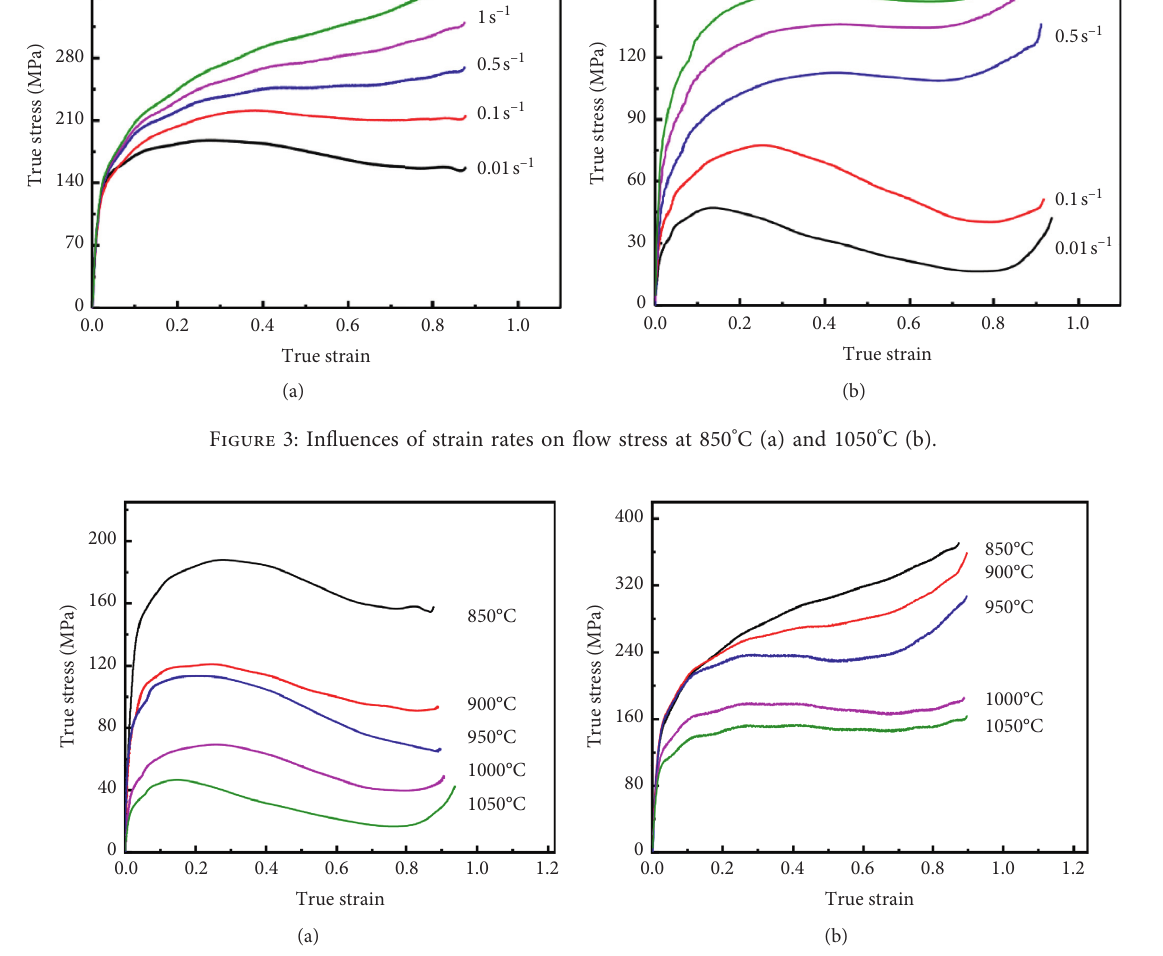
Figure 4: Influences of temperatures on flow stress at strain rates 0.01s − 1 (a) and 0.5s − 1 (b).